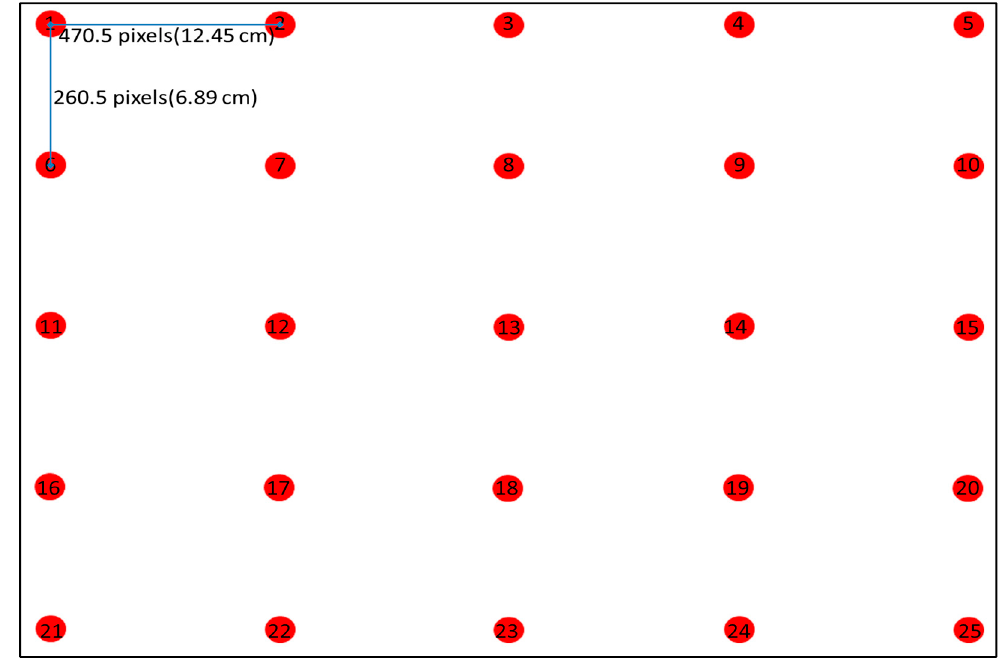
Figure 5. 25 gaze regions defined for training on the 24-inches monitor screen.